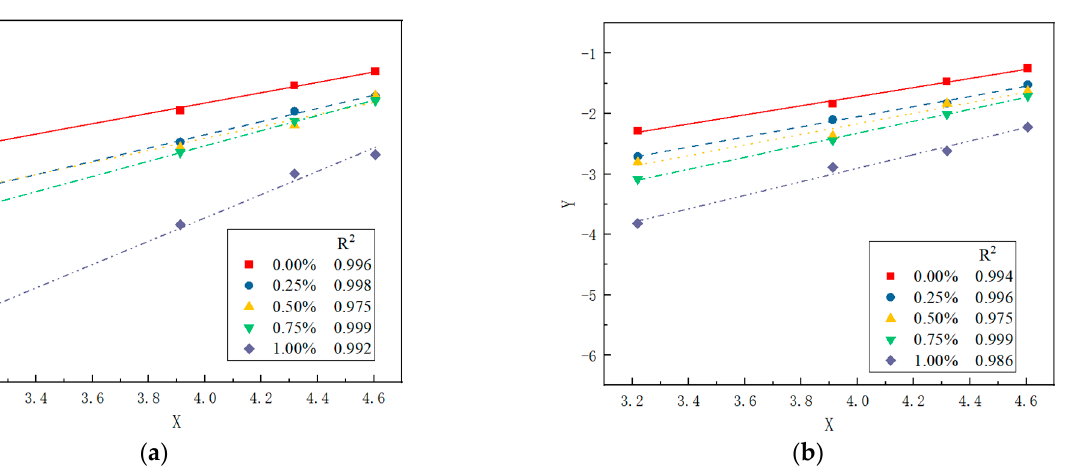
Figure 10. Fitting curve of compressive strength and freeze-thaw cycles of PRGRC in the strength attenuation model: ( a ) 6 mm POM fiber; ( b ) 12 mm POM fiber. Table 3. Linear regression parameters of strength attenuation.